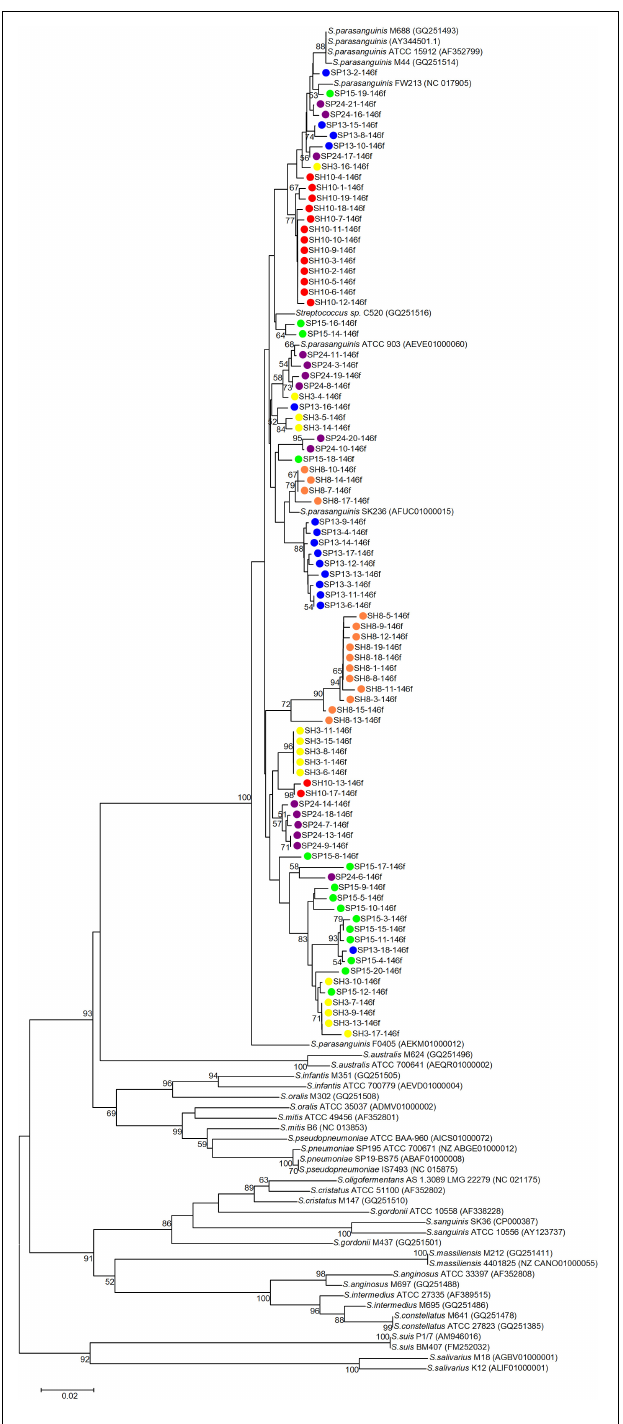
FIGURE 1 | Phylogenetic tree of the groEL gene fragments cloned by the primer pair Spa146f-Spa525r from the saliva of six human subjects and those of known Streptococcus species. The cloned sequences of the present study are labeled by dots of varied colors, and clones of the identical color are from the saliva sample of one person. Strains of known Streptococcus species retrieved from the GenBank are indicated by italics, and the accession numbers of their groEL genes are given in parentheses following the bacterial names. Bootstrap values greater than 50% are indicated at the